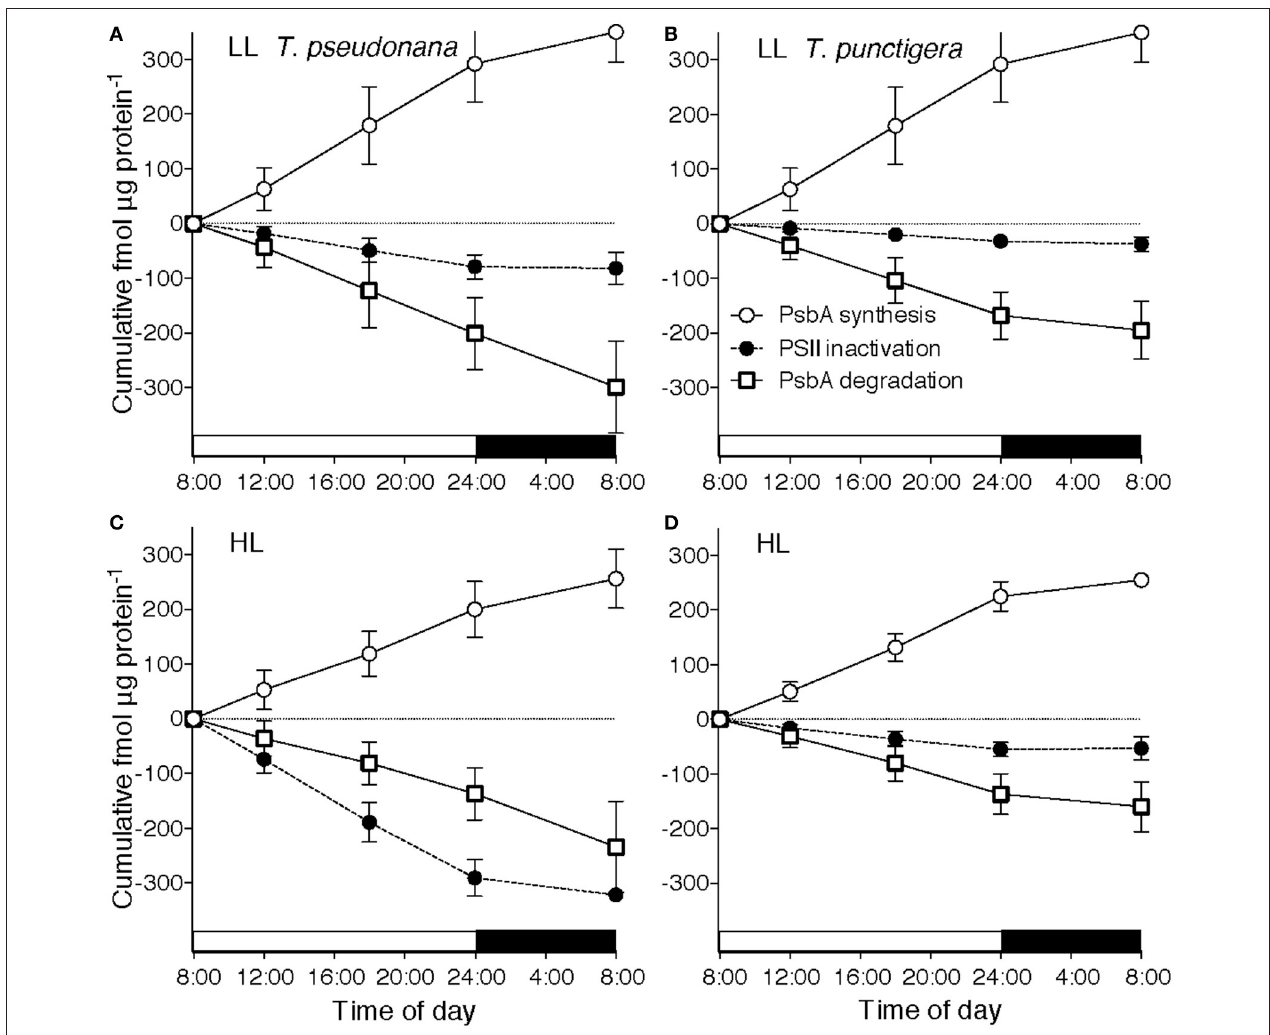
FIGURE 3 | Cumulative diel Photosystem II cycling. Cumulative diel inactivation of Photosystem II (closed circles), cumulative diel removal of PsbA (open squares) and cumulative diel synthesis of PsbA (open circles) for T. pseudonana (A,C) or T. punctigera (B,D) grown under 75 (A,B) or 300 (C,D) µ mol photons m − 2 s − 1 . 16:8 L:D Diel cycle indicated by horizontal bars along X axes. Error bars show propagated standard